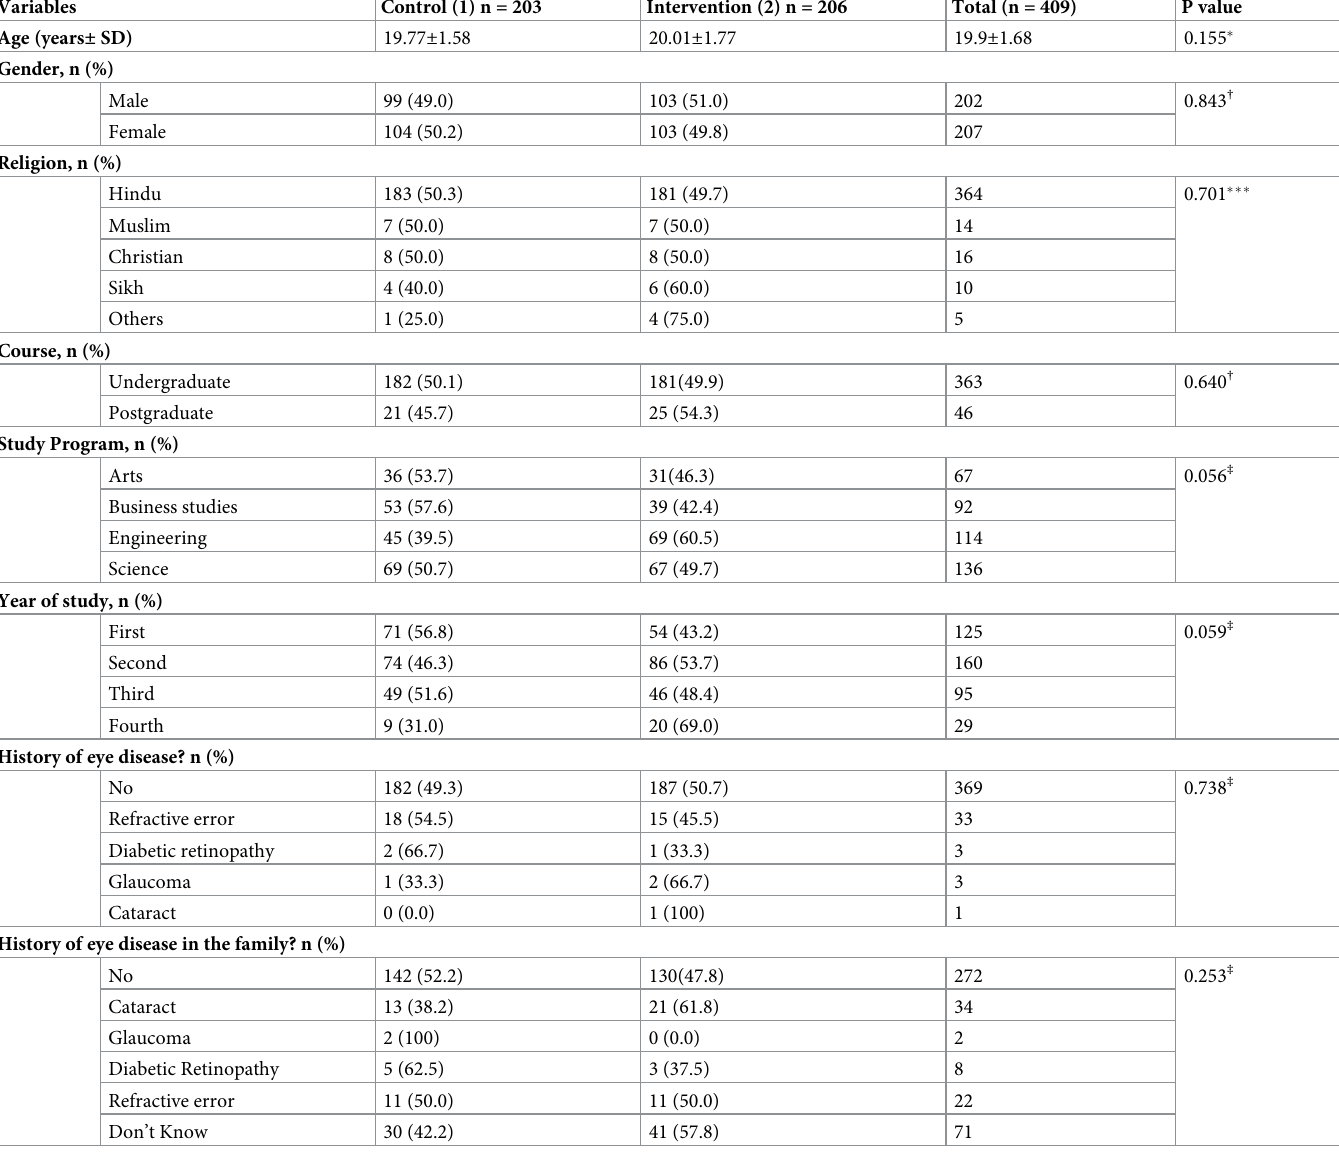
Table 1. Homogeneity of demographic characteristics of the participants at the